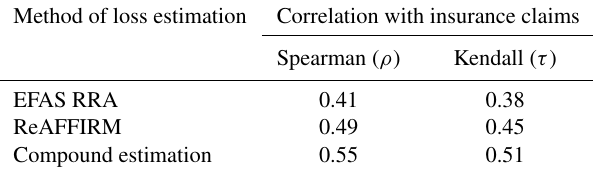
Table 5. Correlation coefficients of economic losses (simulated by the individual methods and their combination) with the insurance claim database (CCS, 2020) in the 907 municipalities inside the do-